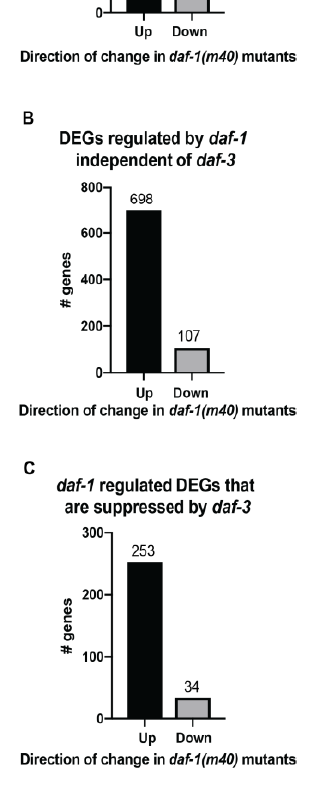
Figure 3. General trends of the differentially expressed genes (DEGs). The bar graphs represent the number of up and down regulated genes in daf-1 ( m40 ) mutants in ( A ) All DEGs in the daf-1 vs. N2 dataset. ( B ) DEGs in the daf-1 vs. N2 dataset that are regulated by daf-1 independent of daf-3 . ( C ) DEGs that are differentially regulated by daf-1 and daf-3 . The number above each bar denotes the number of genes.